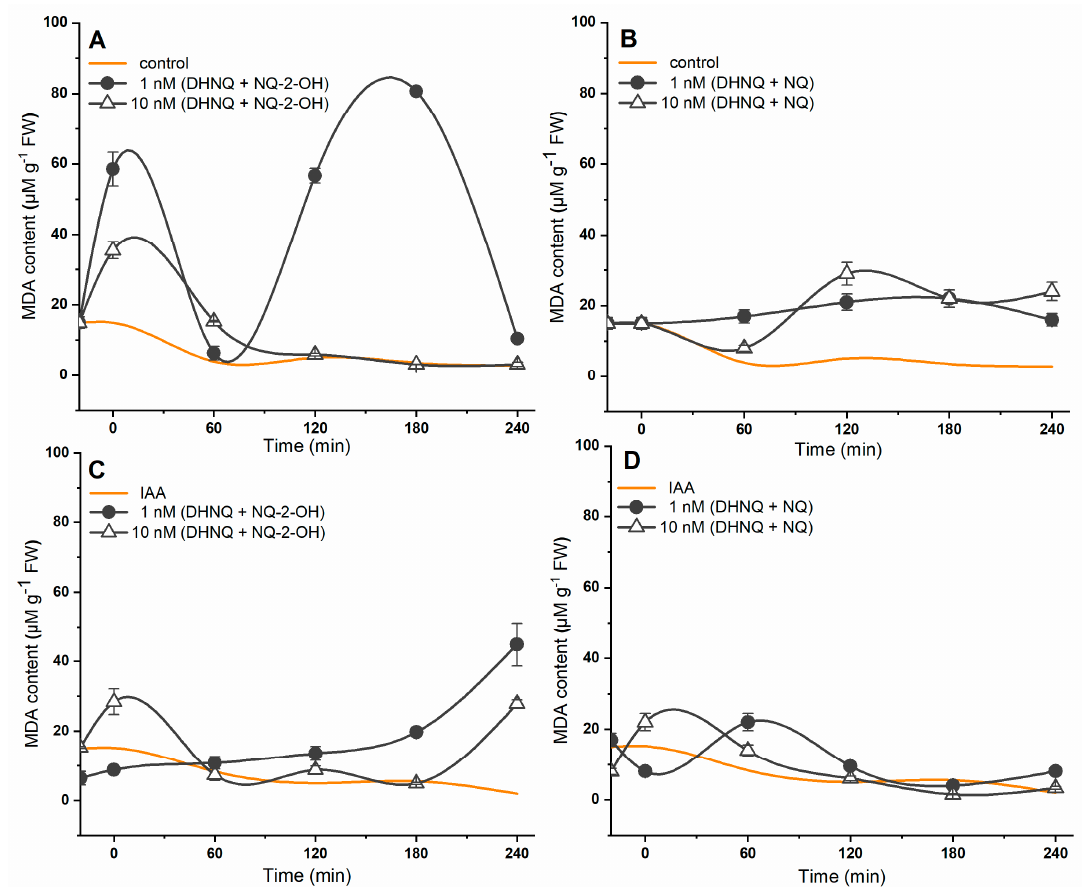
Figure 6. The effect of DHNQ combined with NQ-2-OH or NQ on lipid peroxidation, which was measured as the MDA content in the maize coleoptile segments that had been incubated ( A , B ) without and ( C , D ) with IAA. The presented data is the mean of six independent experiments. Bars indicate the means ± SEs.